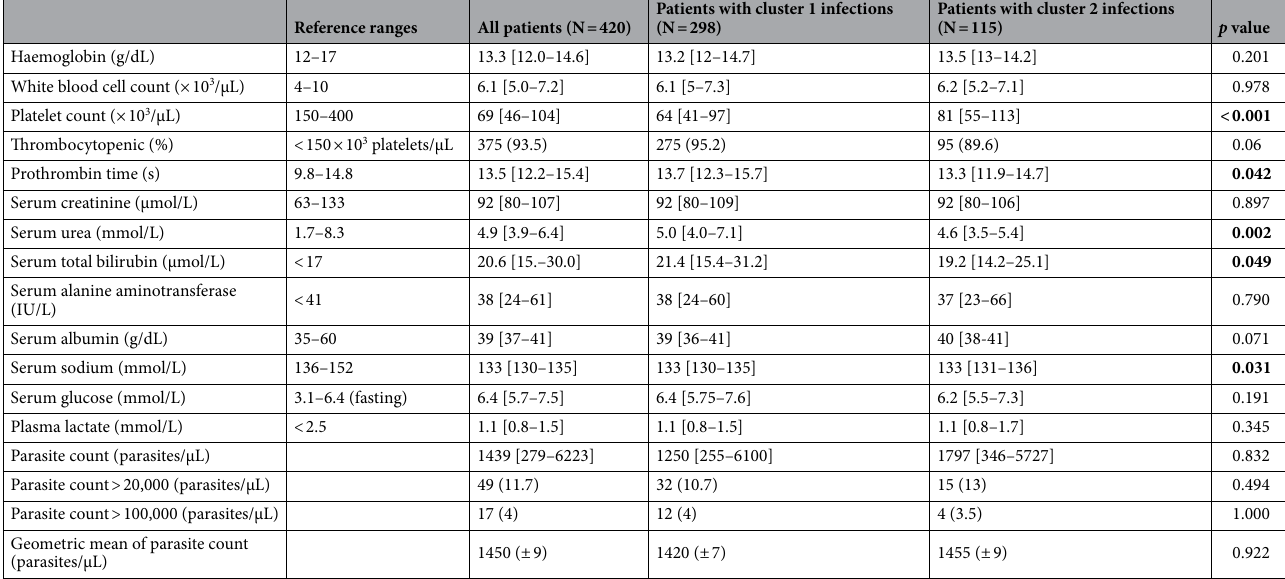
Table 3. Baseline laboratory findings of patients with P. knowlesi infections. Data are presented as no. (%), mean (± SD) or median [IQR]. p value < 0.05 are in bold. p value is between cluster 1 and cluster 2.